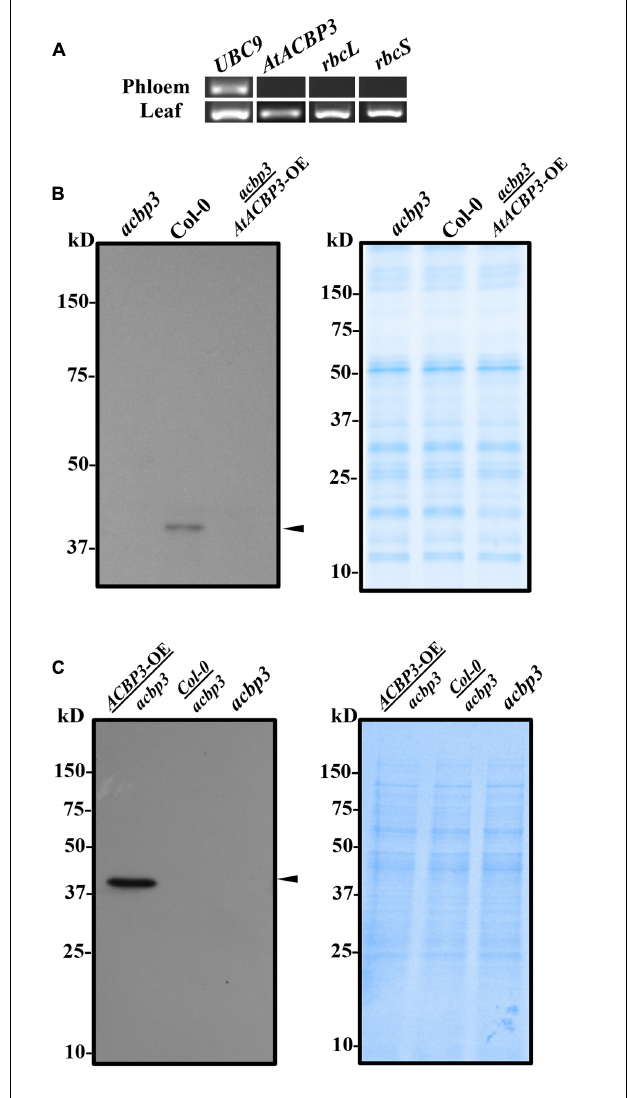
FIGURE 1 | Reverse transcription PCR and western blot analysis of phloem exudates from Arabidopsis. (A) Total RNA was collected from phloem exudates and rosette leaves of Col-0 to detect AtACBP3 and controls ( UBC9 , rbcL, and rbcS ) transcripts. Original images of the analysis are available in Supplementary Figure S2. (B) Western blot analysis using anti-AtACBP3 antibodies on 30 µ g total phloem exudate proteins from the acbp3 mutant, wild-type Col-0 and acbp3 scion grafted on AtACBP3- OE rootstock ( acbp3 / AtACBP3- OE) (left). A Coomassie Blue-stained gel loaded with the same amount of protein in western blot analysis is shown (right). (C) Western blot analysis using anti-AtACBP3 antibodies on 30 µ g total root